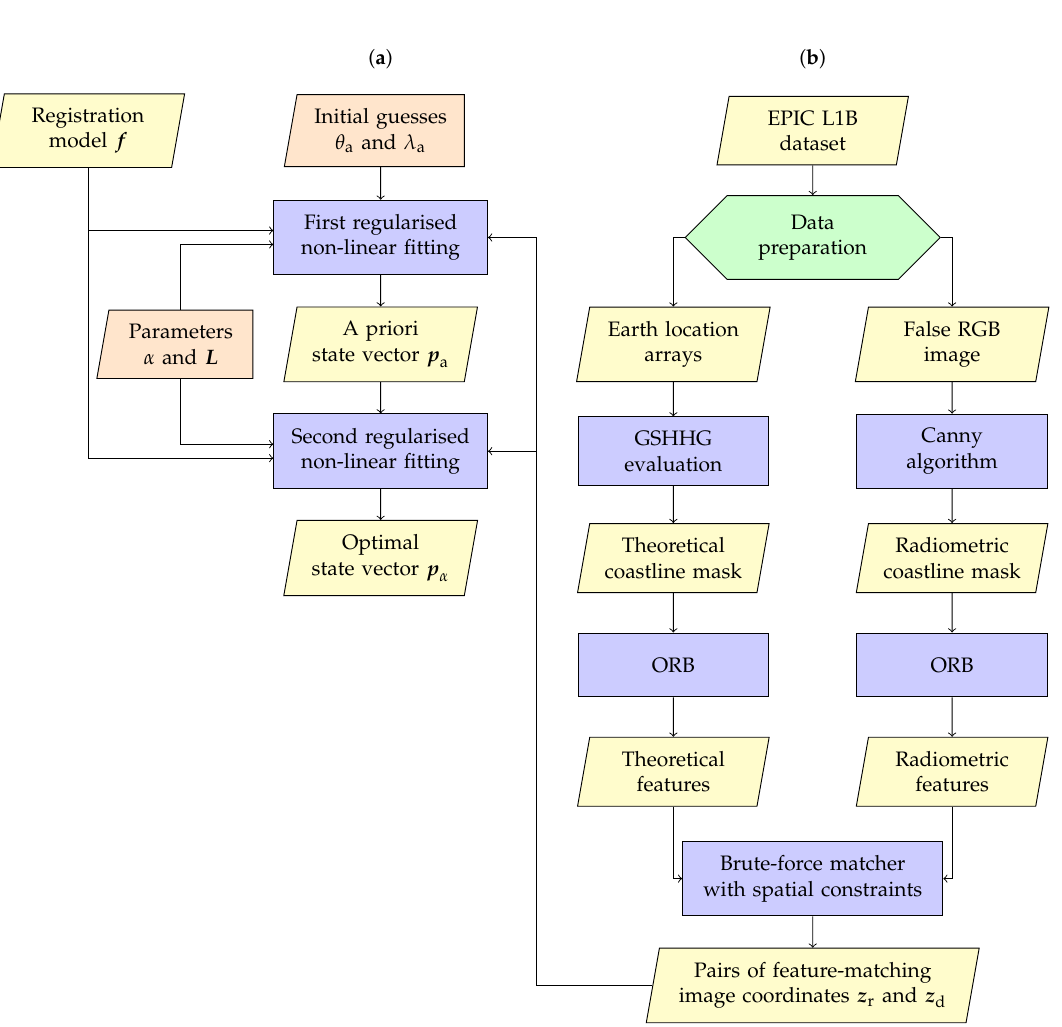
Figure 2. Workflow chart for the computation of the optimal transformation parameters for a given image. ( a ) Main workflow chain in which the non-linear least squares fitting with regularisation is performed. ( b ) Secondary workflow chain in which the known data vectors z r and z d are